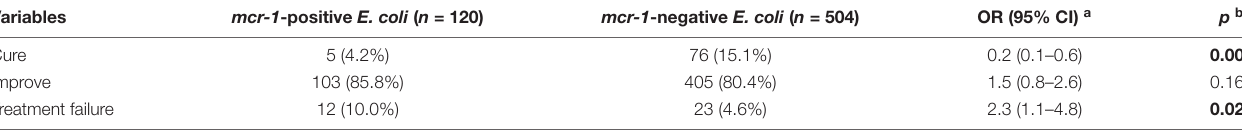
TABLE 3 | Patient outcomes with mcr-1 -positive E. coli and mcr-1 -negative E. coli infections.